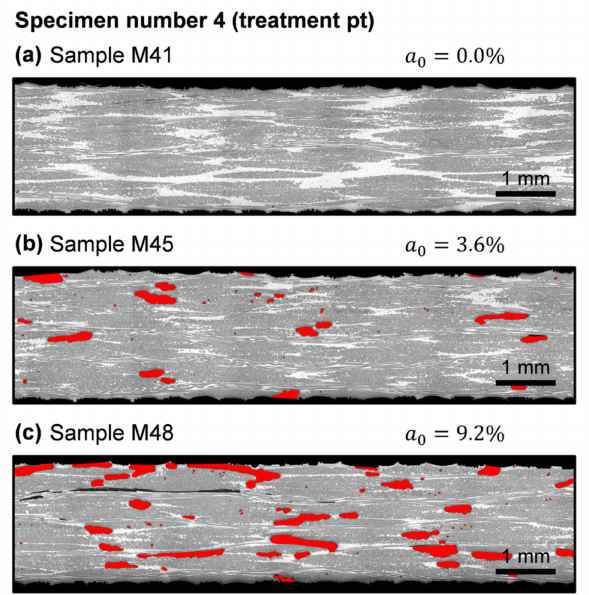
Figure 9. Detail views of micrographic samples belonging to specimen number 4 and void area frac- tion, a 0 , of the corresponding whole sample (not only the partial cross-section depicted): ( a ) Sample M41; ( b ) Sample M45; ( c ) Sample M48.